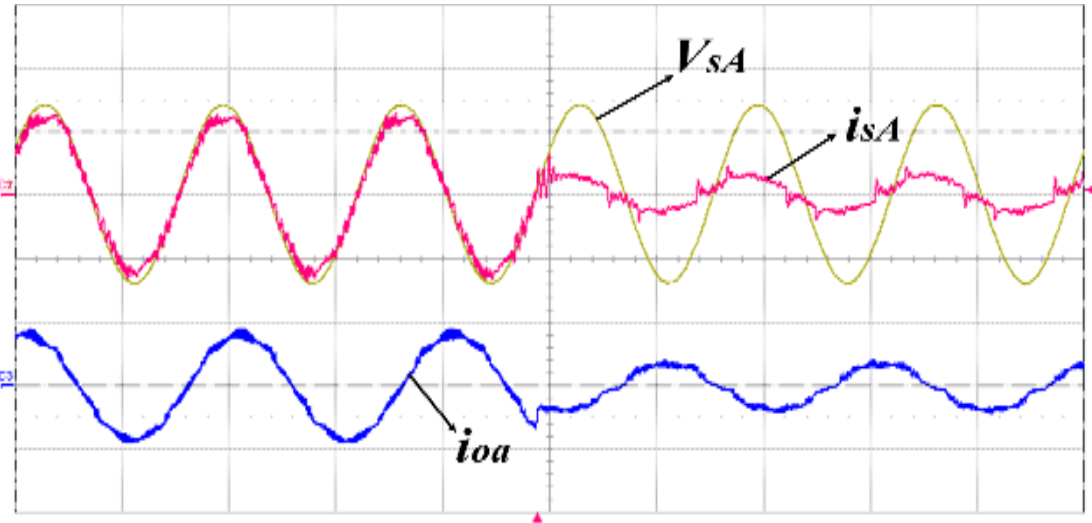
Figure 18. Experimental results of the proposed strategy with the IFRS, where output-current reference amplitude is changed from 4.3 A to 2.15 A and output-current frequency is set to 50 Hz, x-axis 10 ms/div. Waveforms of the source voltage V sA (100 V/div), source current i sA (2 A/div) and output current i oa (5